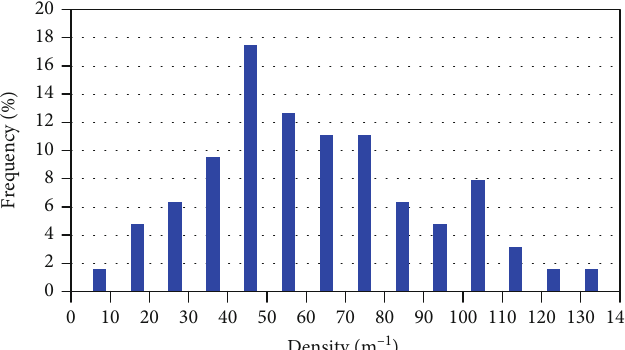
Figure 4: Density distribution of lamellation fractures in the Qianjiang Depression ( N = 828